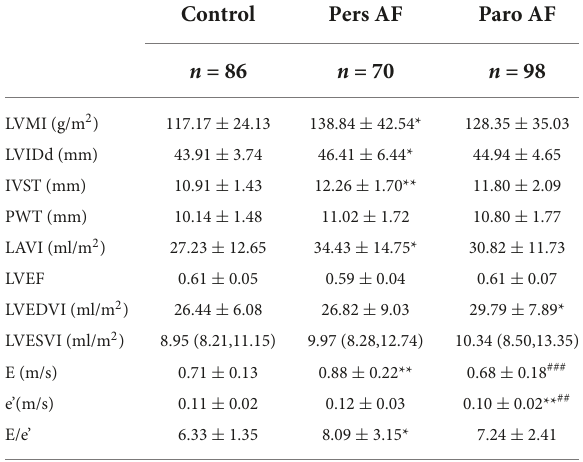
TABLE 2 Comparison of conventional echocardiographic parameters among subjects with different types of AF.